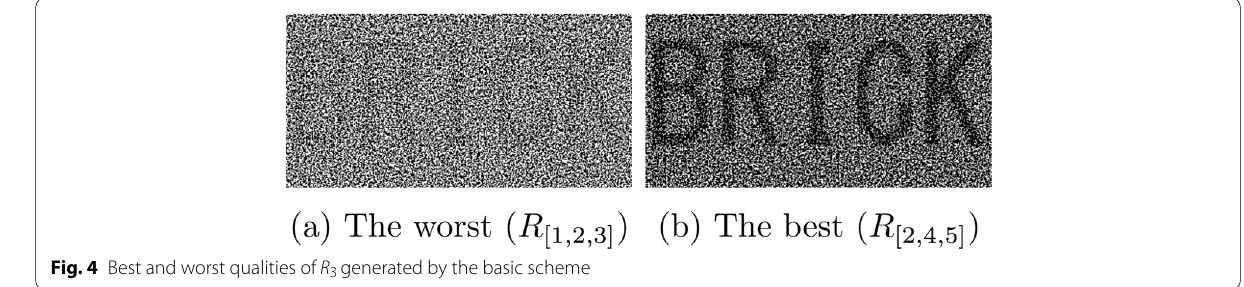
Fig. 4 Best and worst qualities of R 3 generated by the basic scheme